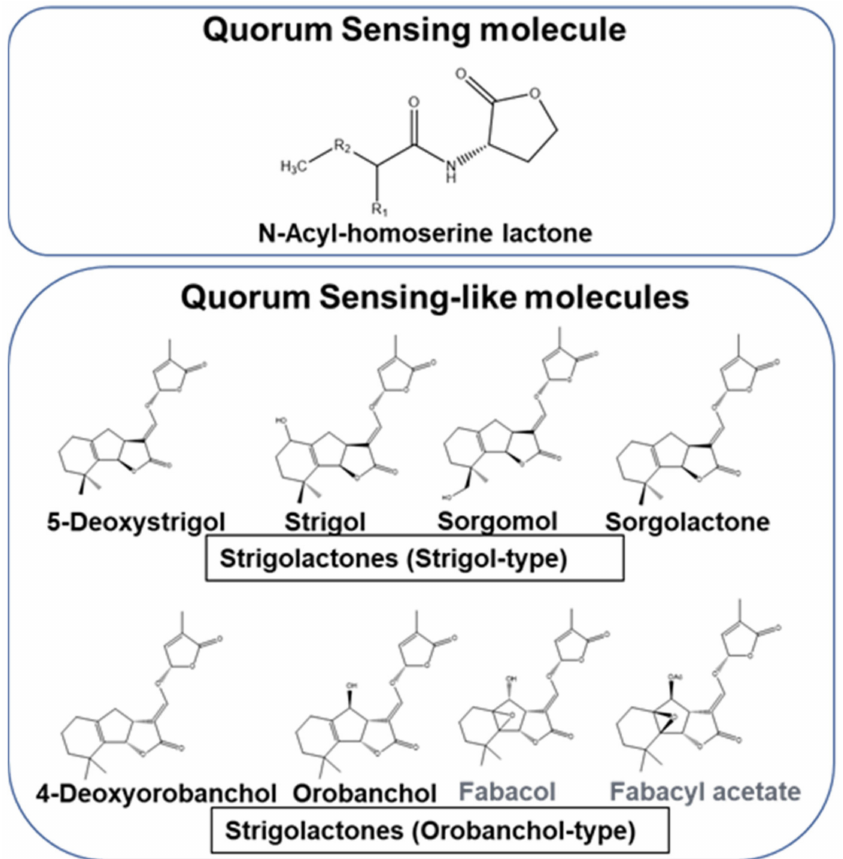
Figure 1. Chemical structure of quorum sensing and -like signal molecules: acylhomoserine and strigolactones. R1: H, OH or O. R2: (CH 2 ) 2–14 .